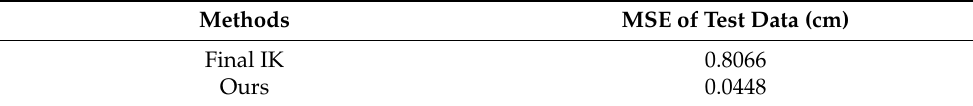
Table 1. MSE values for j 4 , j 5 , j 6 , j 7 , j 8 , and j 9 . Joints Table 2. MSE values of the test data.